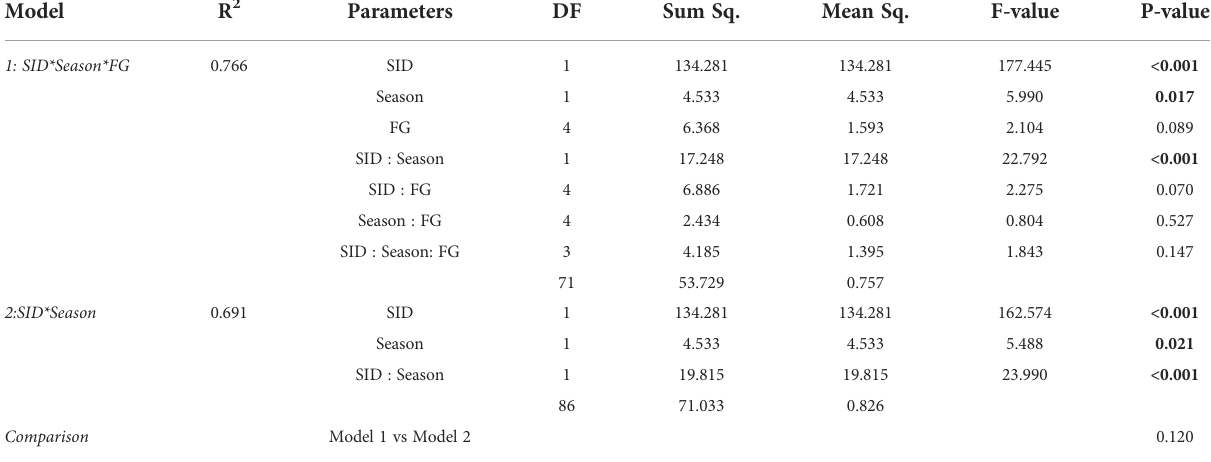
TABLE 3 Model diagnostics for regression models conducted on logit-transformed data from stations south of 79°N. Model R 2 Parameters DF Sum Sq. Mean Sq.